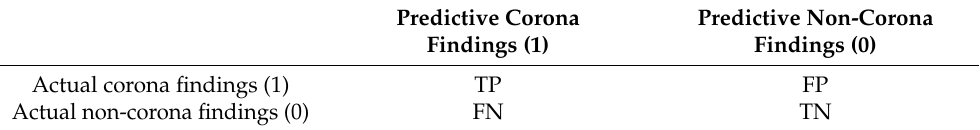
Table 6. Confusion matrix for corona and non-corona cases.